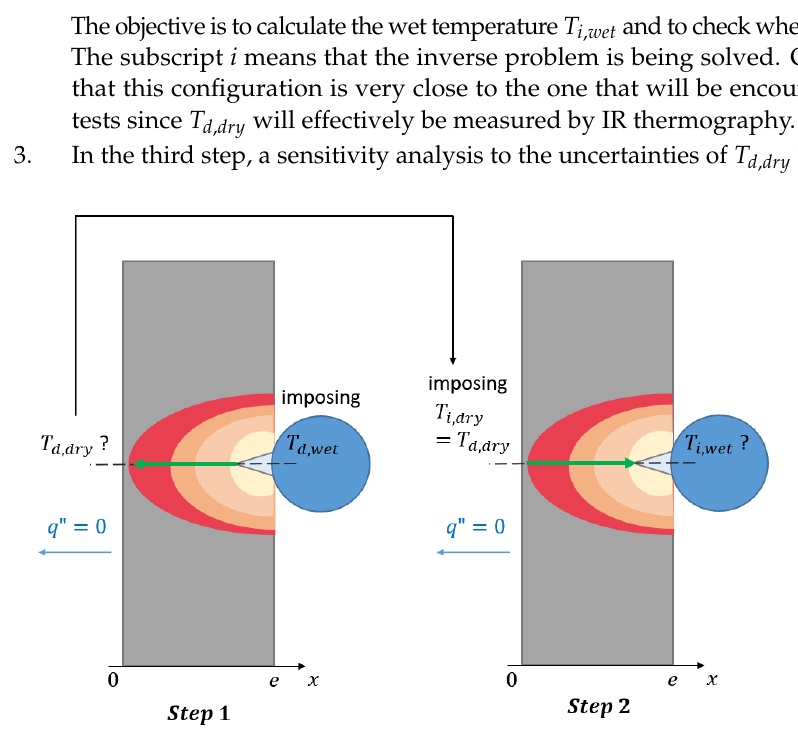
Figure 7. Steps 1 and 2 of the thickness determination